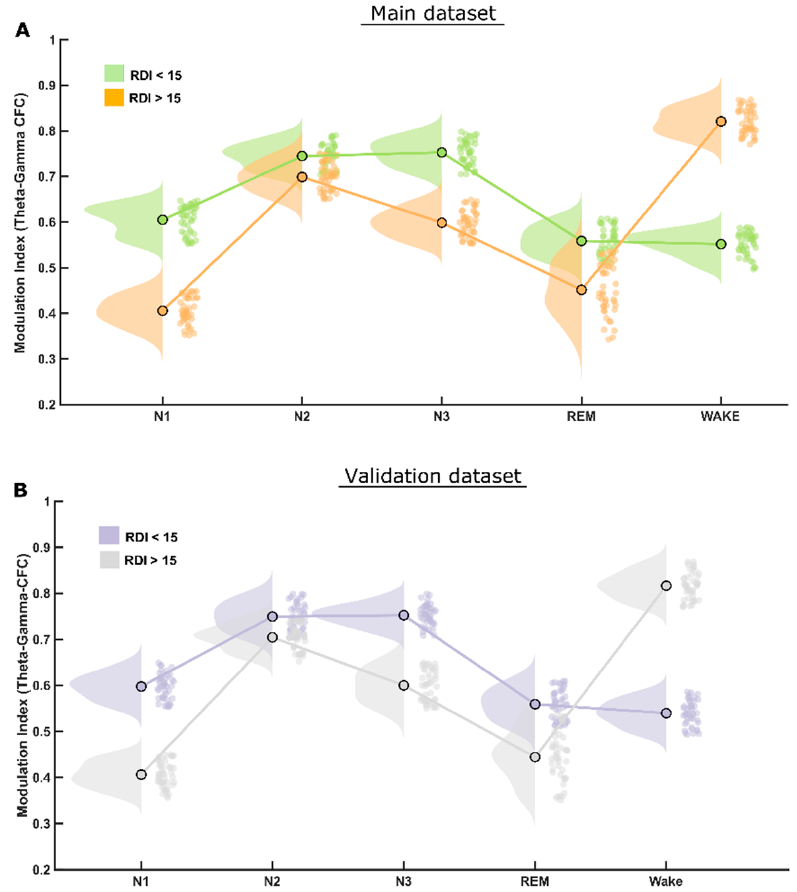
Figure 2. MI differences in theta–gamma CFC . ( A ) The raincloud plot clearly illustrates that patients of the RDI > 15/h group have significantly lower theta–gamma CFC modulation index than that of RDI ≤ 15/h group in all (NREM and REM) sleep stages. ( B ) Exactly the same pattern was found in both the initial and the validation patient groups.